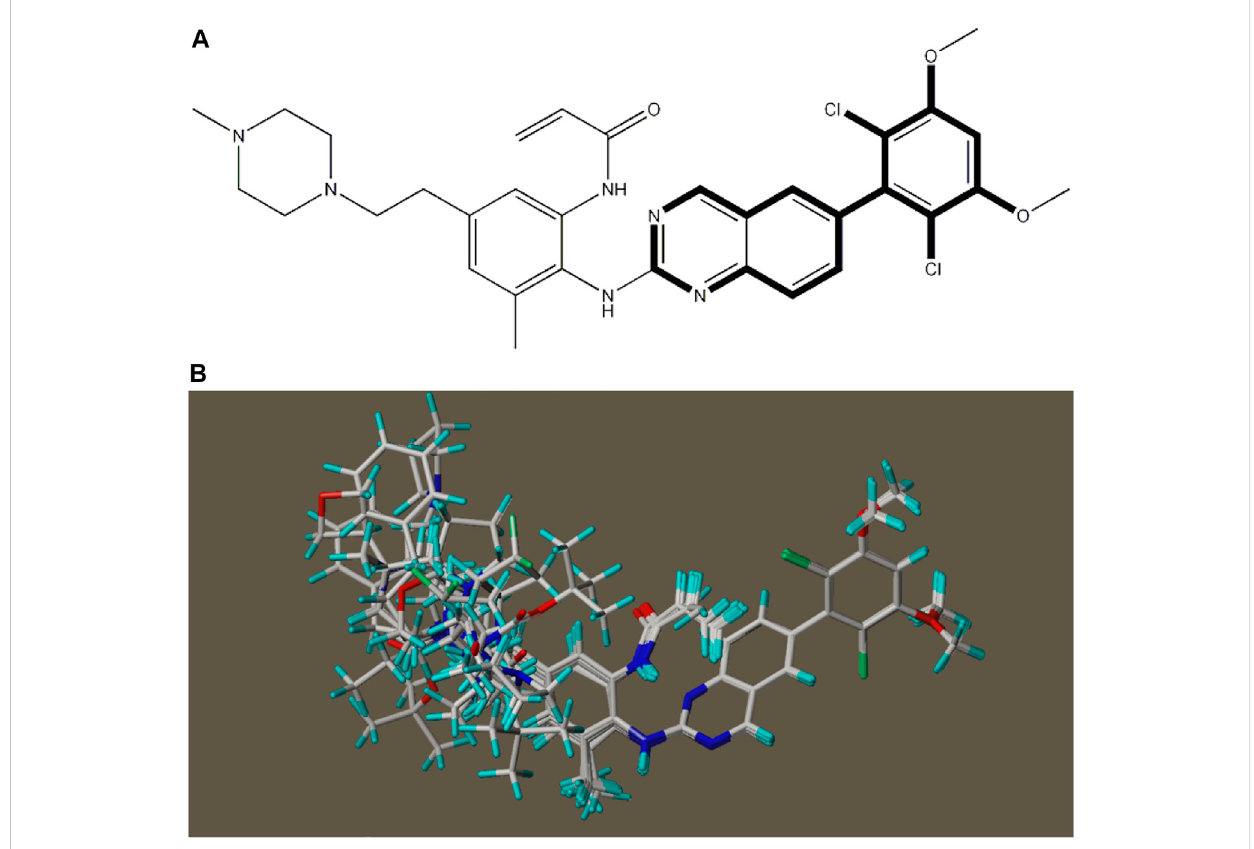
FIGURE 2 Compound 19g serves as a template for the alignment of all compounds. (A) Common alignment structures in compound 19g (shown in bold), and (B) all compounds are aligned with 19g as a template.